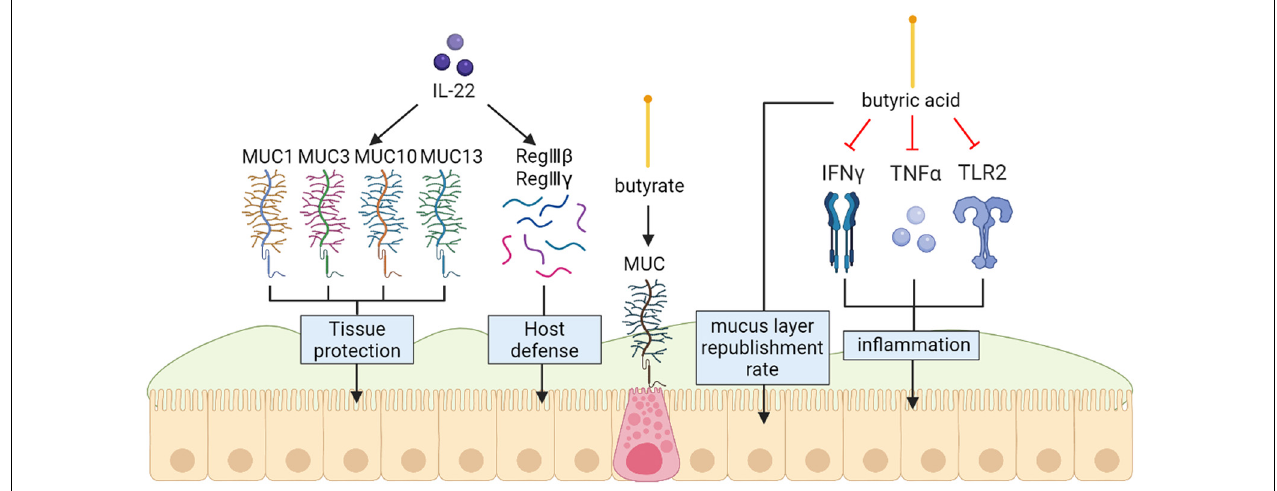
FIGURE 1 | Mucins (MUC) protect the intestinal epithelial barrier. Exogenous IL-22 involved in producing protective mucus (MUC1, MUC3, MUC10 and MUC13) and induce expression of antimicrobial peptides including RegIII β , RegIII γ . Butyrate specifically modulates MUC gene expression in intestinal epithelial goblet cells deprived of glucose Inflammatory responses in the gut can be retarded by butyrate through reducing the expression of INF- γ , TLR2, and TNF- α in vitro